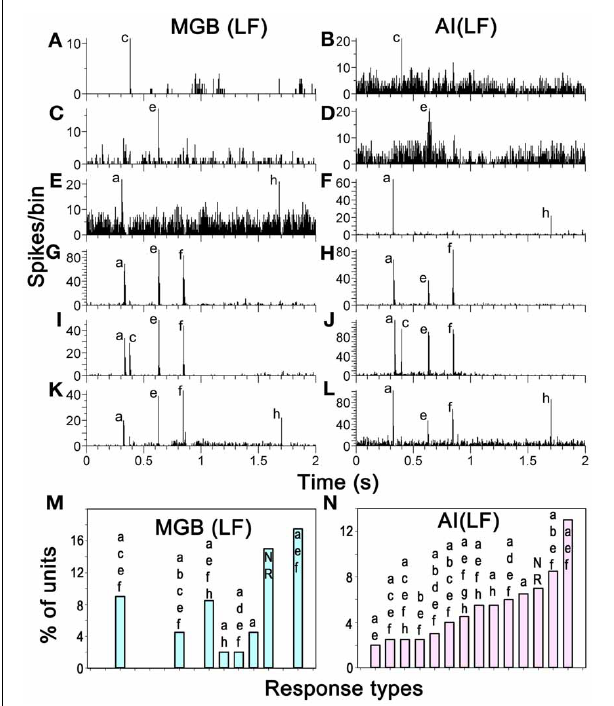
FIGURE 7 | (A–L) PSTHs showing matched pairs of distinct response combinations to the chutter by units in MGB(LF) and AI(LF). Some units only responded to one element while others responded to two, three or four elements as indicated by the labels. (M, N) Proportions that particular response combinations made in each structure. The 14 most common combinations in AI(LF) are shown as the proportion of the total number of units and the corresponding proportion for each combination is shown for MGB(LF).